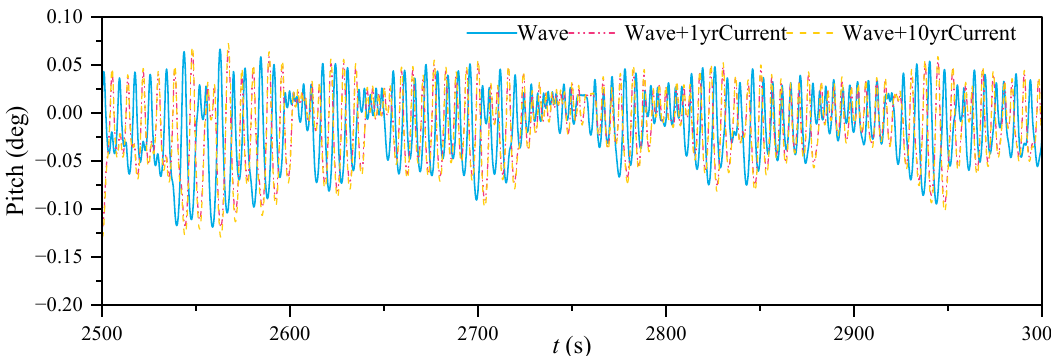
Figure 17. Pitch response under wave load and current load.